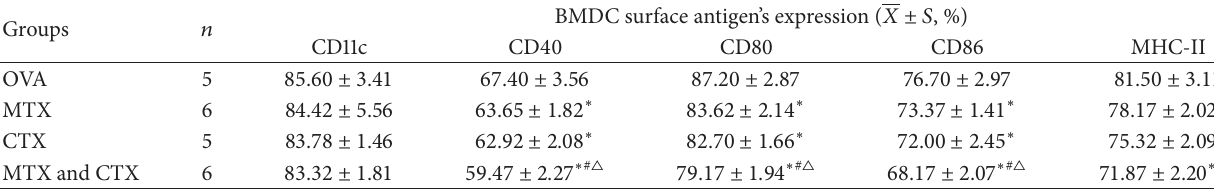
Table 6: Comparison of DC surface antigen’s expression in each group on 9th week. Groups